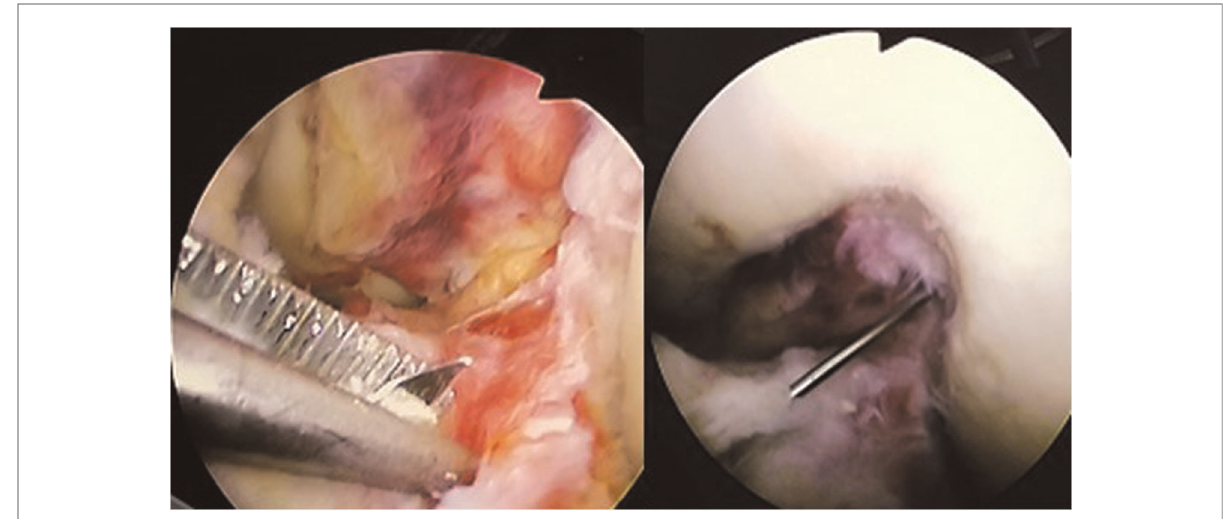
FIGURE 4 Arthroscopic view: maintain the position of the guide needle and insert the hollow drill.